Question: What kind of plot is shown here?
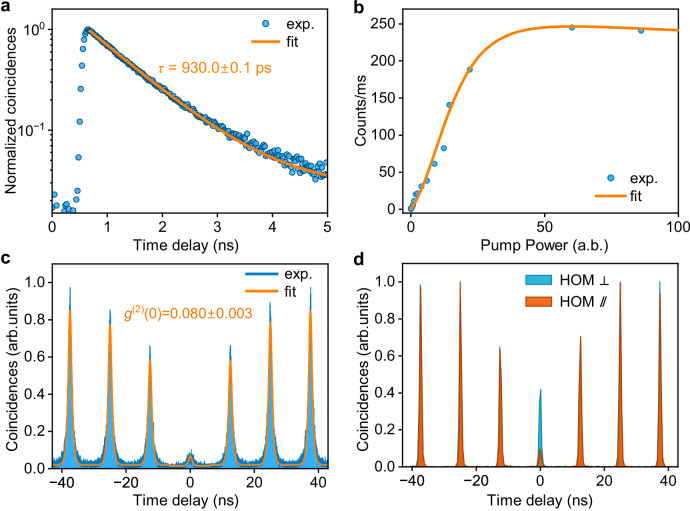
Answer: histogram